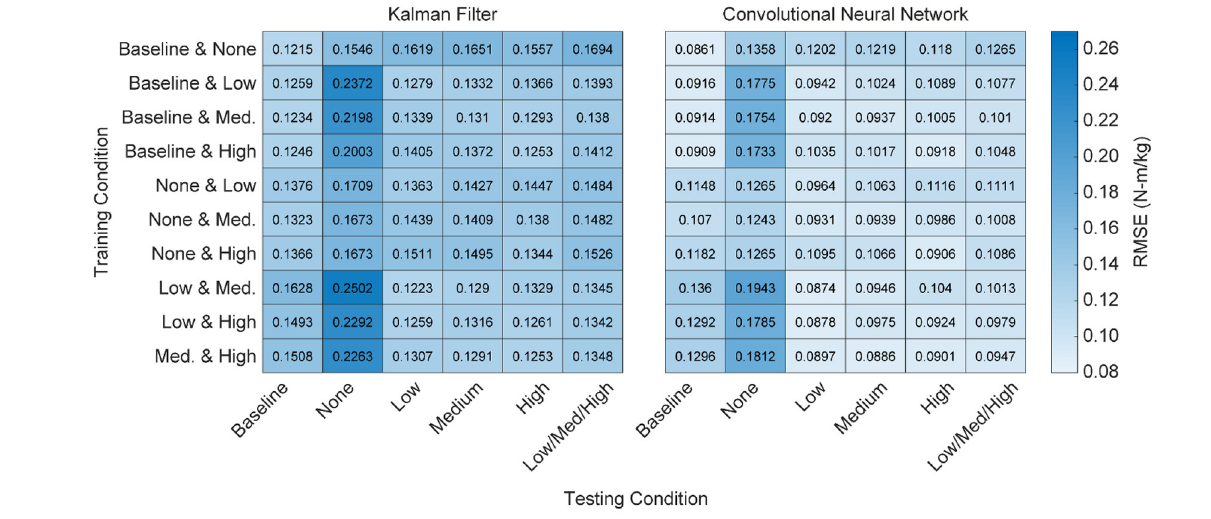
FIGURE 6 | Heatmap of algorithm performance using various pairwise training approaches. Performance is shown as RMSE (N-m/kg) of algorithm predictions relative to the ground truth values of right and left hip torque in the sagittal plane. Lighter colors represent lower RMSE and better performance. Training with higher levels of exoskeleton assistance generally resulted in better performance. That is, when participant time is limited and only a subset of training conditions can be used, emphasis should be placed on higher levels of exoskeleton